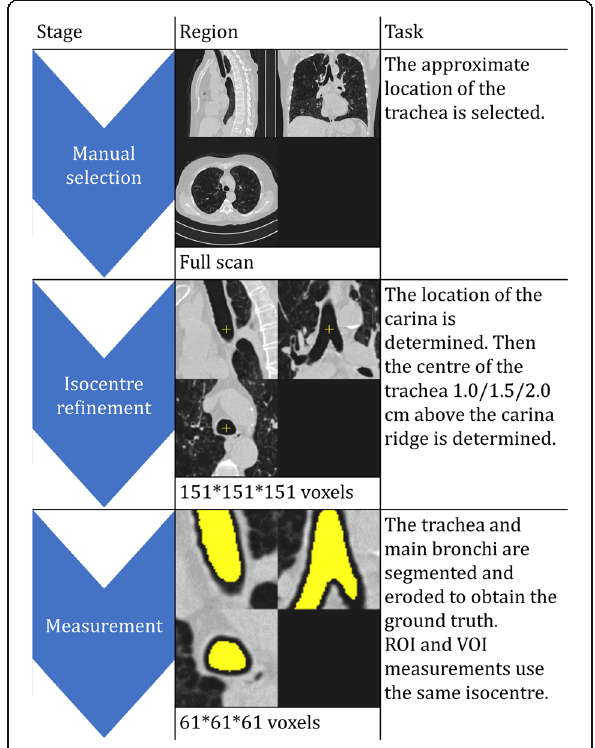
Fig. 1 Flow chart of the steps to determine the ground truth noise and the isocenter for the measurements. ROI, region of interest; VOI, volume of